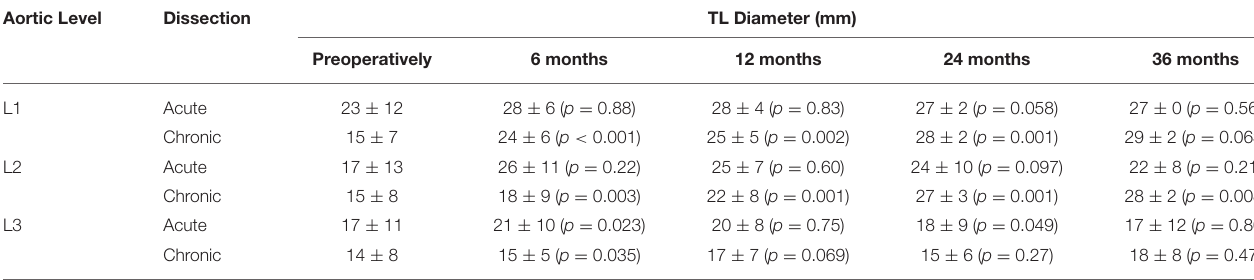
TABLE 2 | Summary of FL diameter results from Berger et al. (Thoraflex Hybrid) (15). Aortic Level